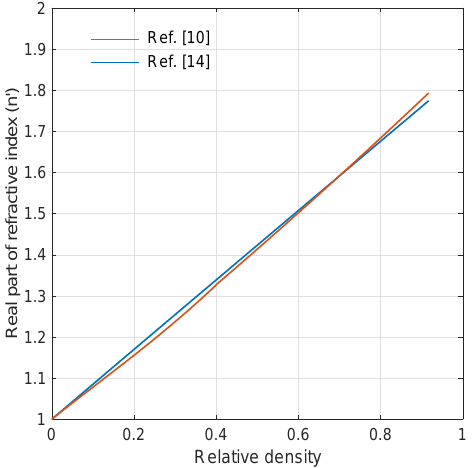
Figure 8. Real part of refractive index vs. the snow density at a frequency of 1 GHz and 0% LWC. Results using [10] and [14] are represented by blue and orange lines, respectively. The linear fit gives n ’( ρ relative ) = 1 + 0.8439 ρ relative .